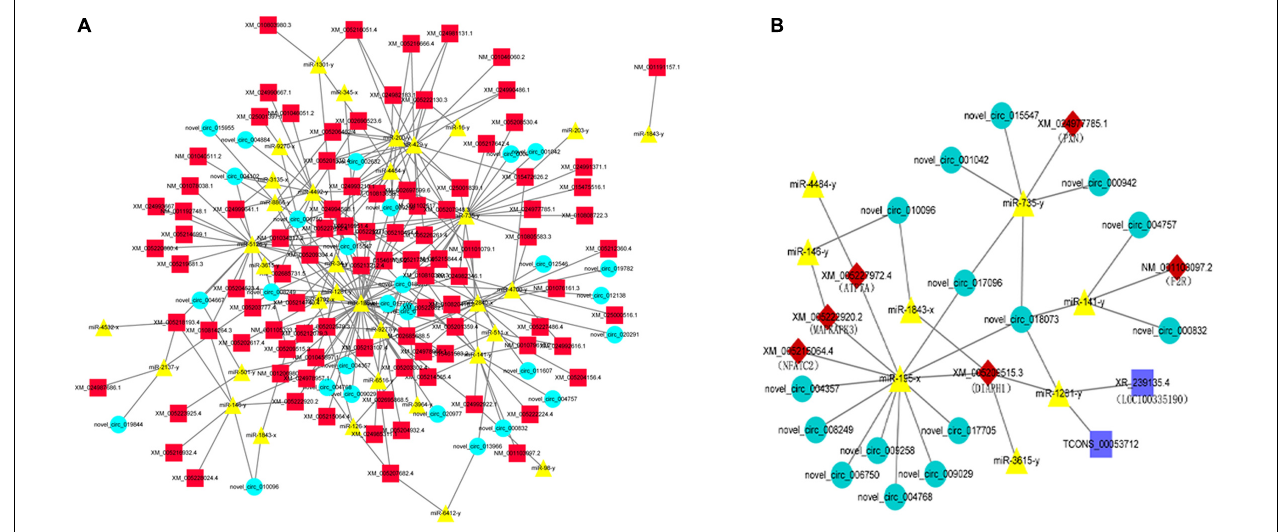
FIGURE 5 | An overview of the competing endogenous RNA (ceRNA) network (A) and the predicted hypoxic ceRNA network (B) . The red squares, green circles, and yellow triangles indicate co-DETs, co-DEMs, and co-DECs, respectively. The dark blue rectangle indicates the differentially expressed lncRNA transcripts in the LAC-vs-LWQY comparison